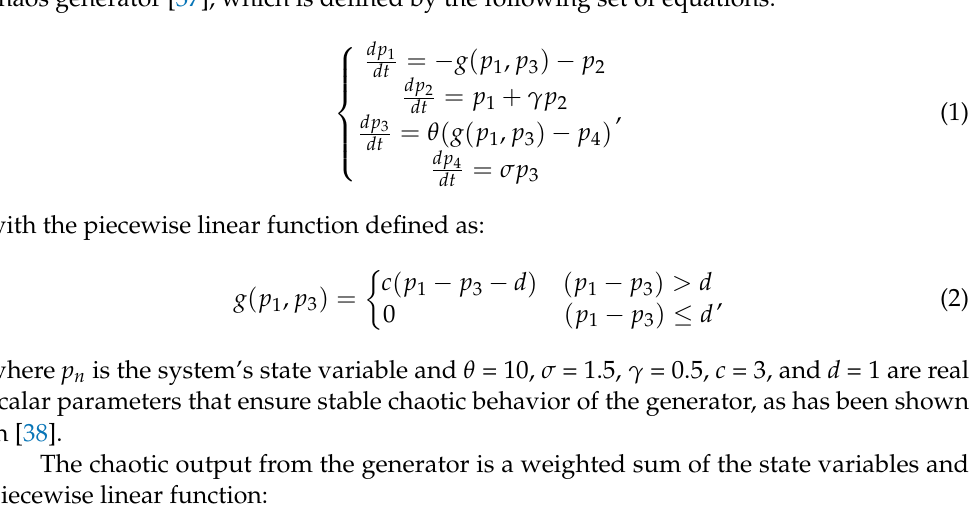
Figure 1. Simplified structure of the proposed chaotic communication system.